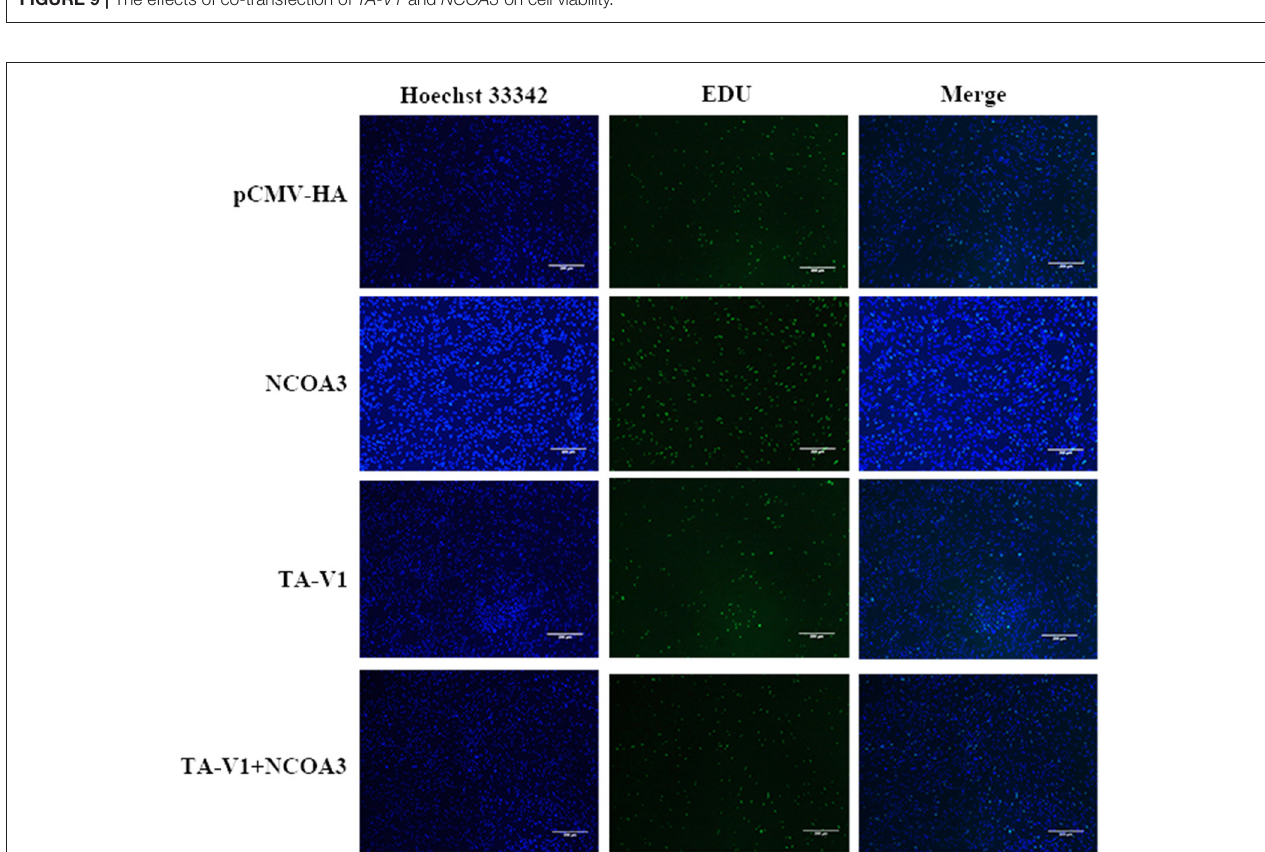
FIGURE 10 | The effects of co-transfection of TA-V1 and NCOA3 on cell proliferation. The effect of co-transfection of TA-V1 and NCOA3 on EdU staining is